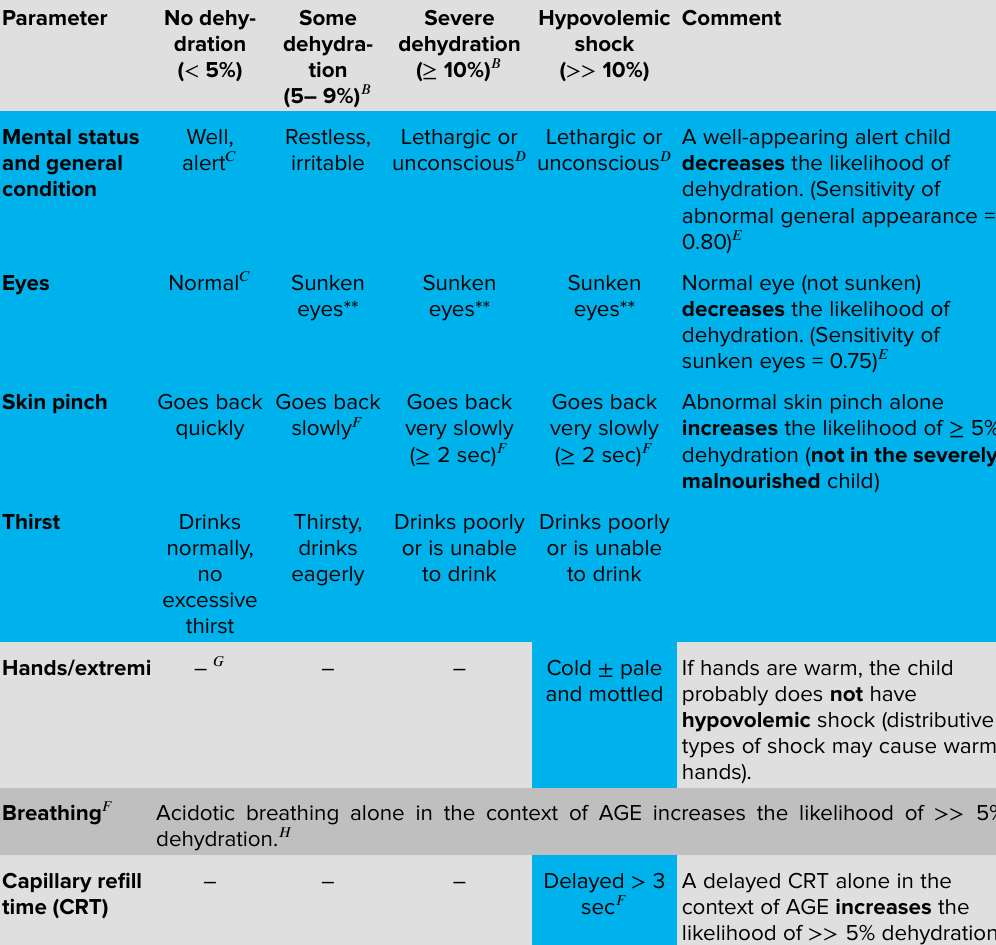
TABLE 1: Assessment and classification of dehydration.